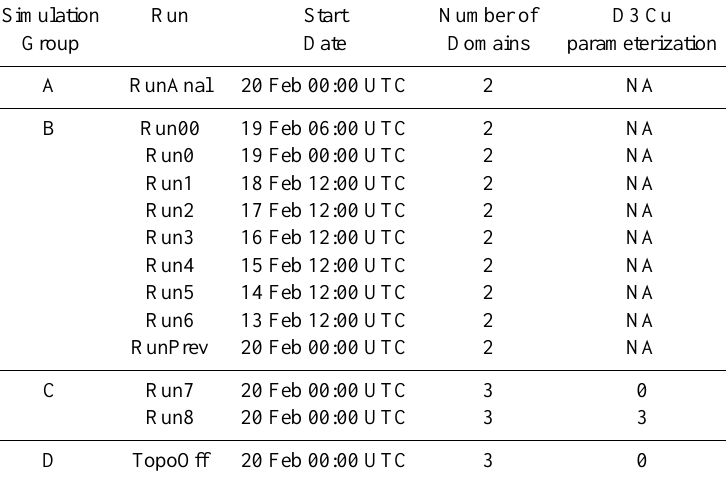
Table 1. WRF simulations. Cumulus parameterization used: 0 No cumulus, 3 Grell-Devenyi ensemble scheme (Grell and Devenyi, 2002)